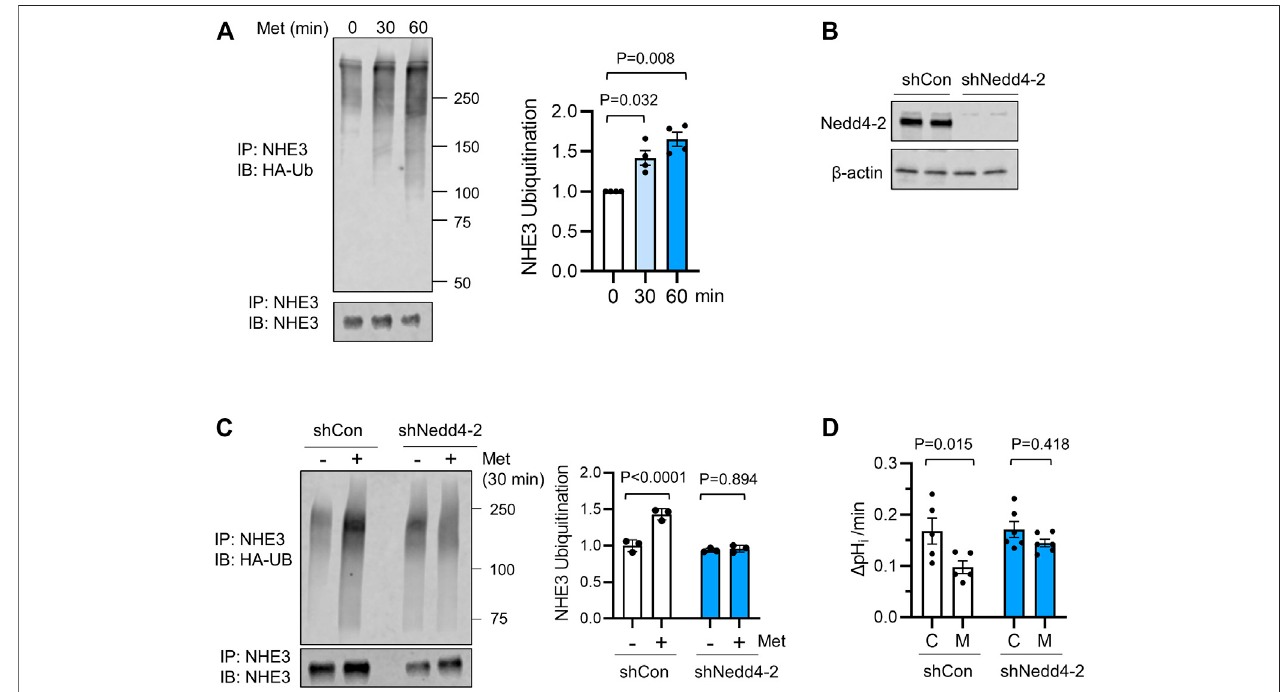
FIGURE 4 | Ubiquitination of NHE3 by metformin is dependent on Nedd4-2. (A) Ubiquitination of hNHE3 was determined in Caco-2bbe cells expressing HA-Ub and treated with metformin. NHE3 was immunoprecipitated using anti-VSVG antibody and blotted with anti-Ub antibody. Lower panel shows immunoprecipitated NHE3. The graph on the right representsthe quanti fi cation of Ub/NHE3 at 0, 30, and 60 min metfromin. n =4. Statistical analysis byone-wayANOVA. The graph on the right represents the quanti fi cation of Ub/hNHE3. (B) Silencing of Nedd4-2 expression in Caco-2bbe/NHE3 cells transduced with shNedd4-2 is shown. (C) Ubiquitination of hNHE3 was determined as described earlier. The graph on the right represents the quanti fi cation of Ub/NHE3 in control ( − ) and metformin-treated (+) cells. n =3. (D) NHE3activitywasdeterminedastherateofNa + -dependentpH i recoveryincellsexpressingshConorshNedd4-2treatedwithmetformin(M)ornot(C).n ≥ 5. One-way